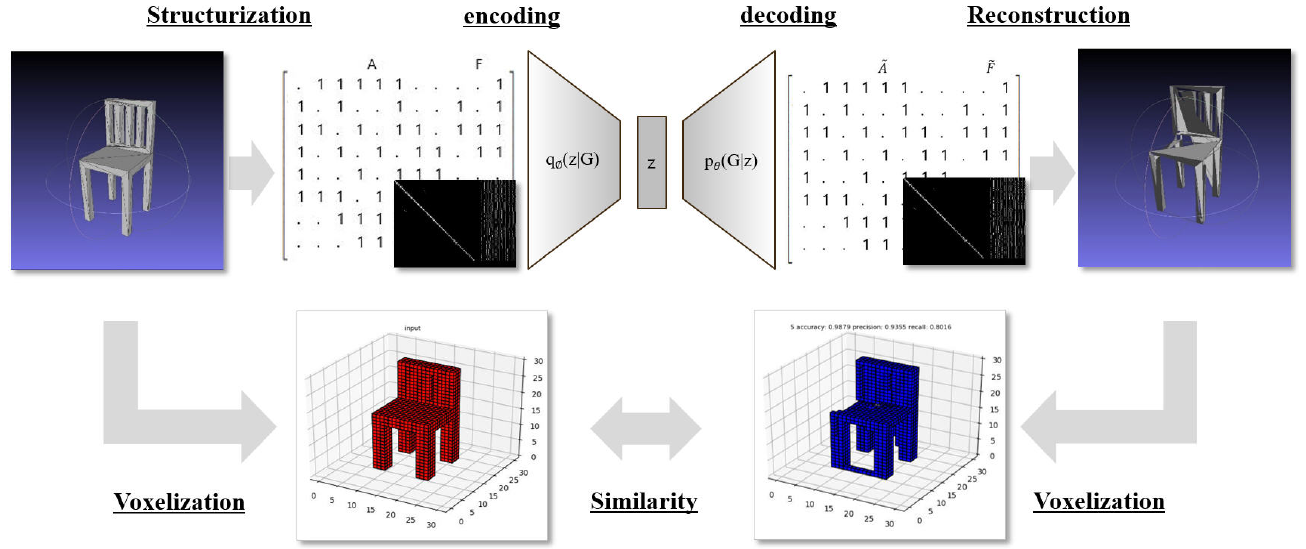
Figure 2. Framework of face-based variational